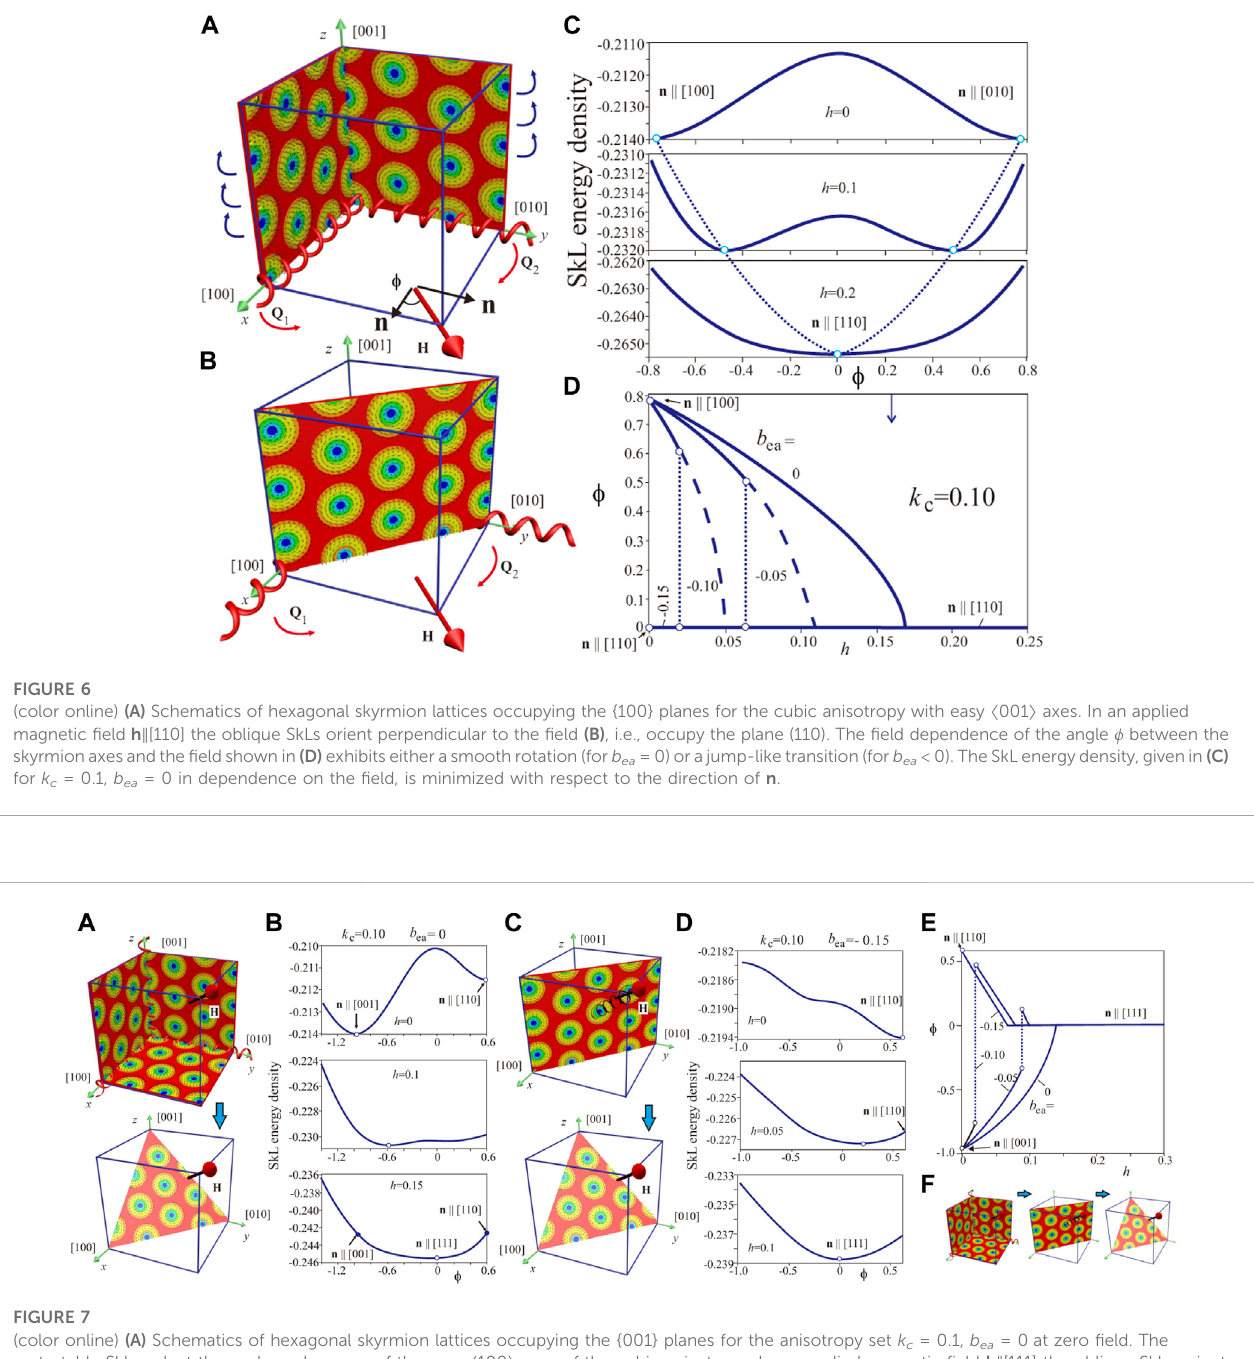
the angle ϕ between the fi eld and the normal n to the SkL plane for different values of b ea . The equilibrium angle ϕ is obtained by the energy minimization procedure, in which we smoothly rotate n in the